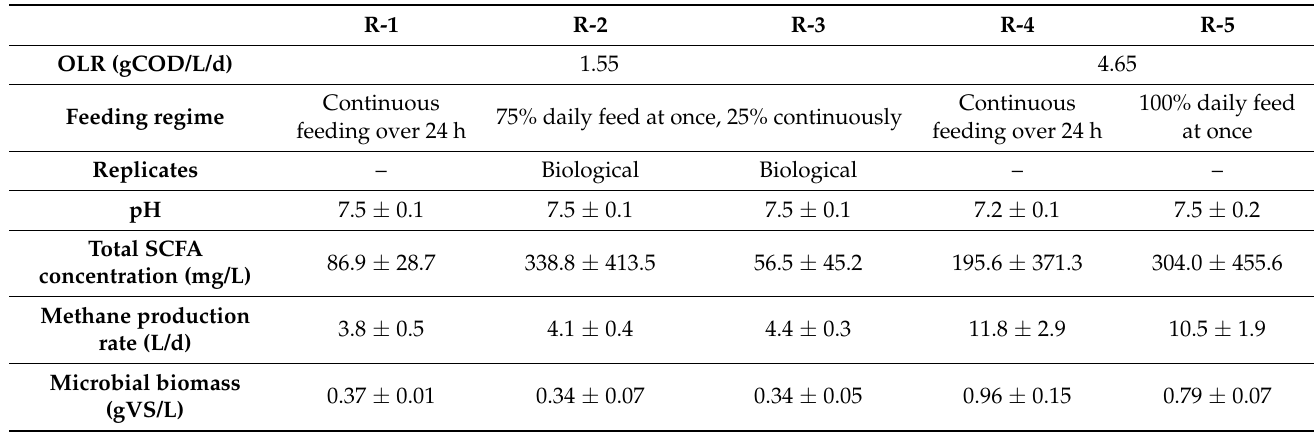
Table 1. Experimental setup and process parameters according to [1]. For discontinuously fed reactors, measurements were taken just prior to feeding; mean values and standard deviation are reported for the stable operating phase (29 days for R-1, R-2, R-3, and 44 days for R-4, R-5) with daily measurements of pH and methane production and weekly measurements of total SCFA and microbial biomass (see Figure S1). COD: chemical oxygen demand; VS: volatile solids.